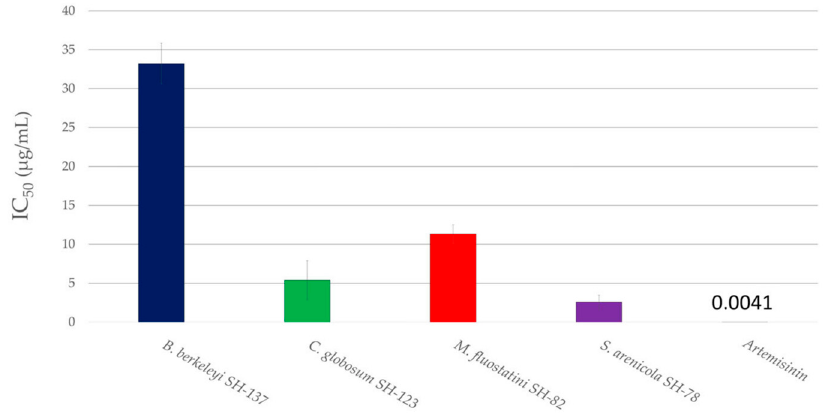
Figure 7. IC 50 of the four microbial extracts of interest against P. falciparum 3D7 strain. The different colors correspond to the different microbial strains.